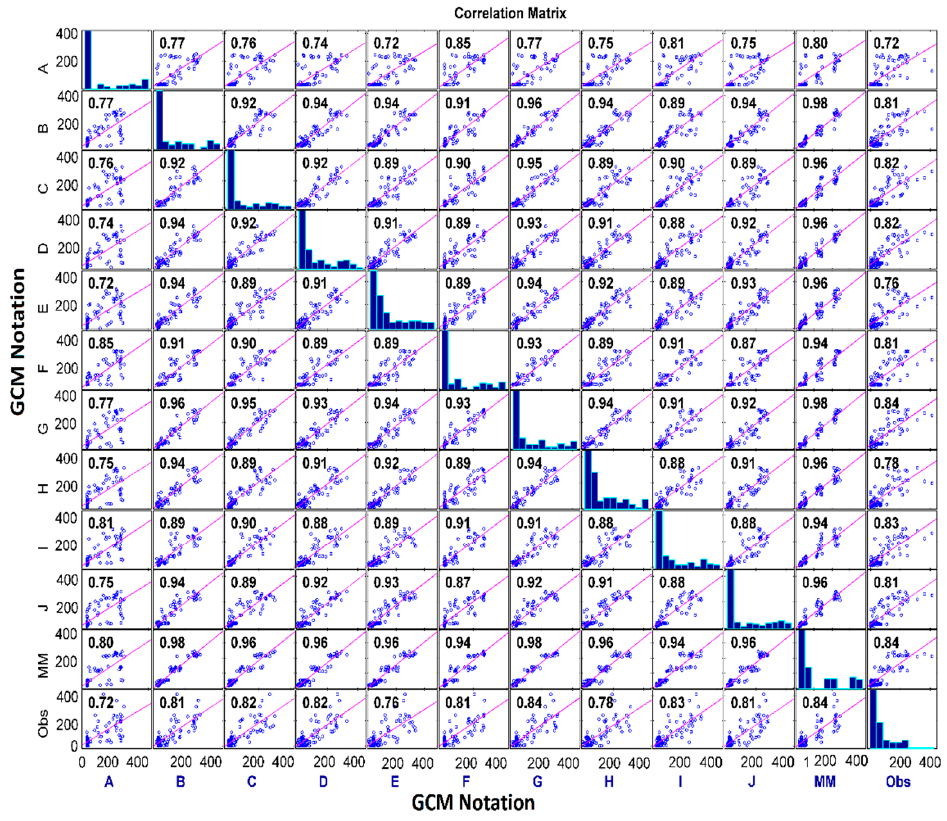
Figure 20. Correlation matrix of downscaled precipitation with different GCMs by the GCM-Obs model for Uttarkashi. Markings are the same as the ones given in Figure 17.